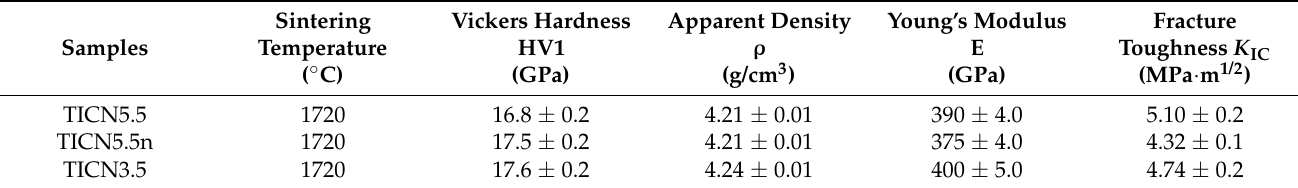
Table 3. Vickers hardness, apparent density, Young’s modulus, and fracture toughness of the tested composites sintered by